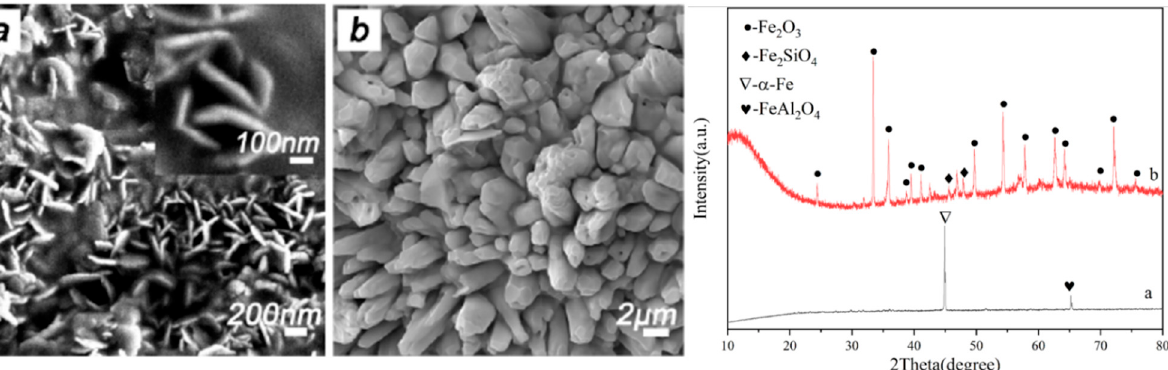
Figure 9. Samples prepared with microwave susceptor for SiC microwave. ( a ) Before heat treatment. ( b ) After heat treatment.